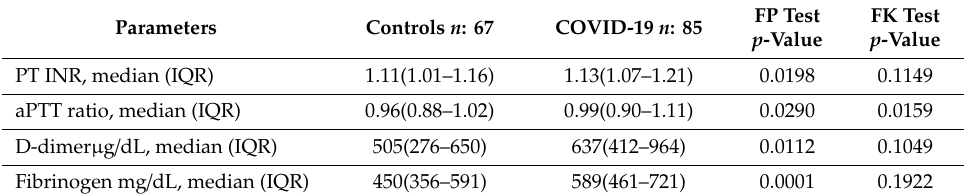
Table 2. Comparisons of laboratory parameters between Control and COVID-19 groups.